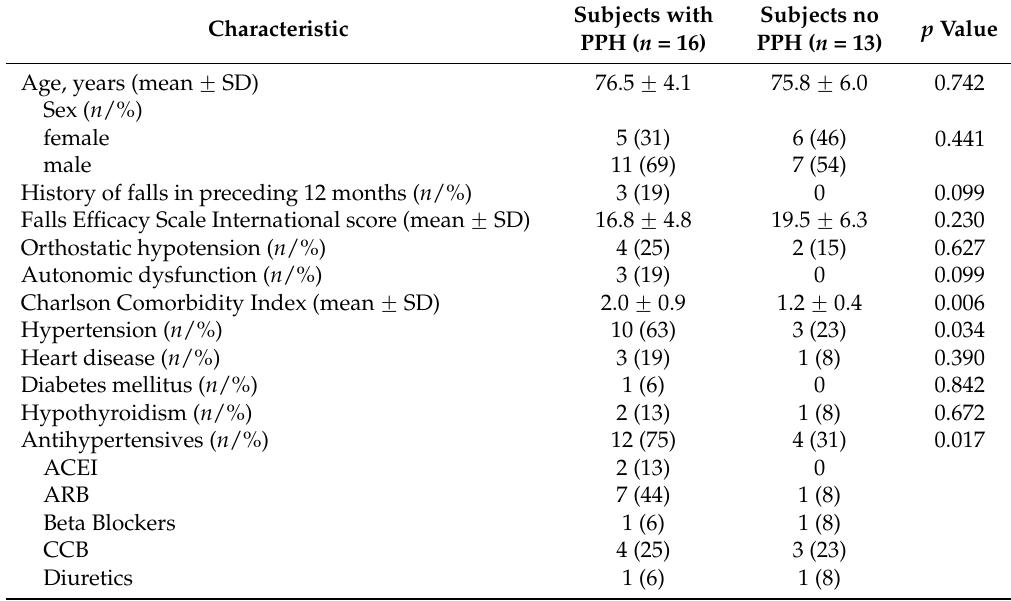
Table 2. Subjects’ characteristics.